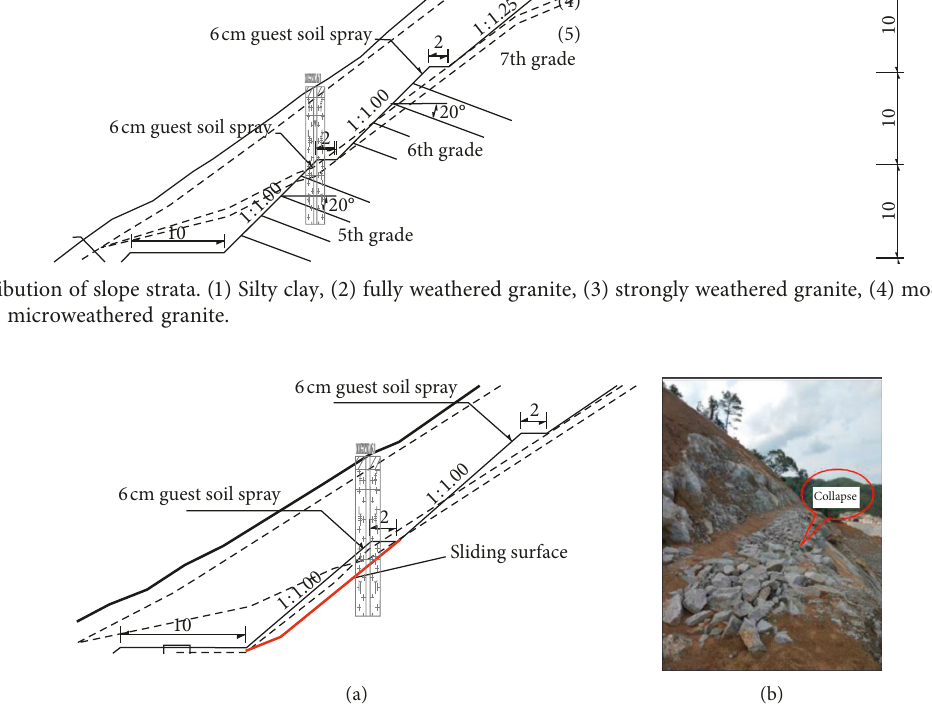
Figure 3: Local collapse of the slope caused by blasting excavation. (a) Sliding surface. (b) Collapse on-site.